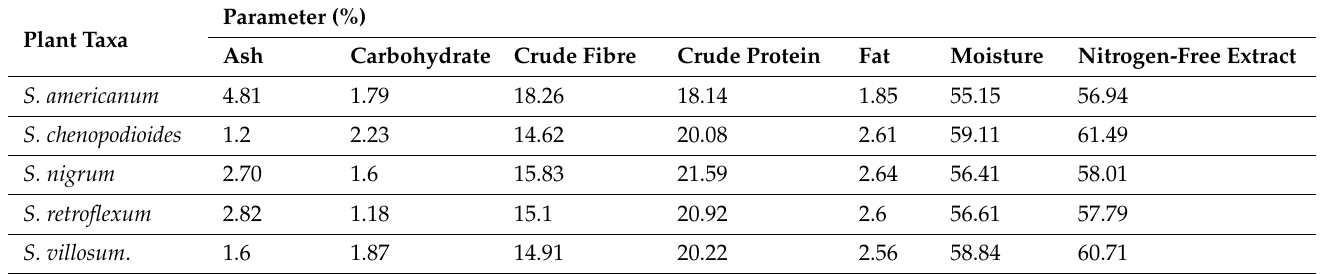
Table 2. Proximate analysis of the S. nigrum complex for its nutritional value.